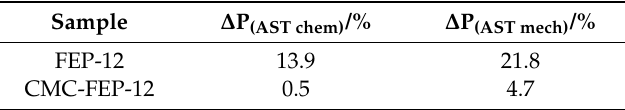
Table 2. Variation of output power density upon ASTs.